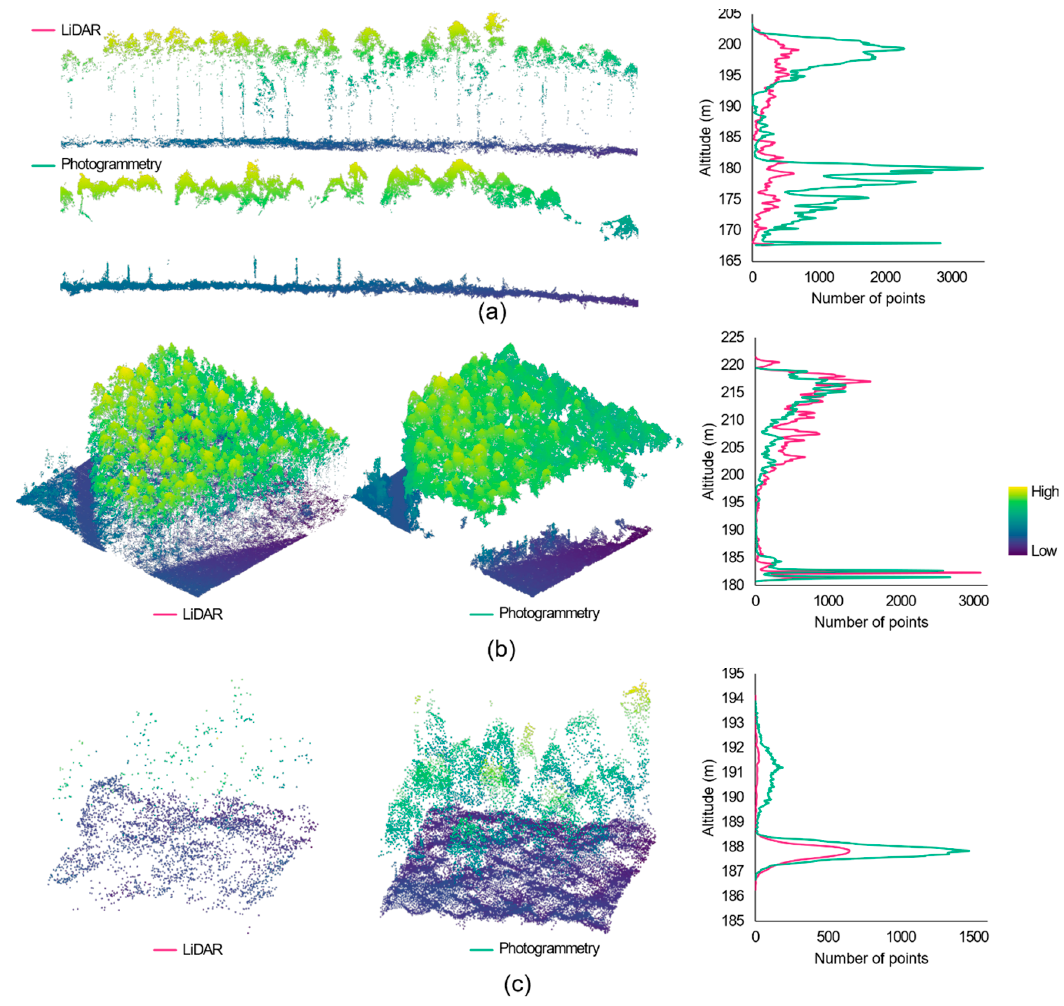
Figure 5. Comparison of a LiDAR point cloud with a photogrammetric point cloud, both acquired using an unmanned aerial vehicle: ( a ) a profile in the limits of a tree plot; ( b ) a dense canopy plot; and ( c ) young coniferous trees. Data courtesy of Aeromedia.